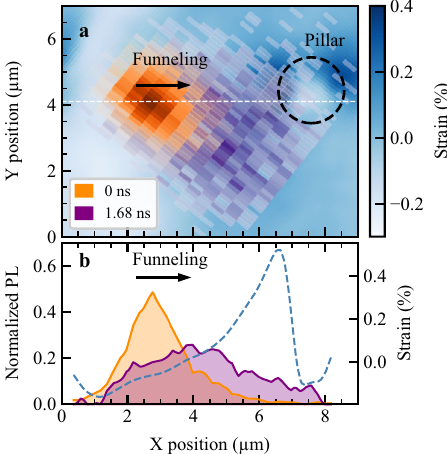
Fig. 4 Conventional exciton funneling in MoSe 2 monolayers. a Spatiotemporal photoluminescence of MoSe 2 shown at Δ t = 0 ns (orange area) and for a delay time of 1.68 ns (purple area) in presence of a strain pro fi le (blue scale). The dashed black circle denotes the position of the micropillar. b Cuts along the white dashed line in a . The dashed blue line shows the spatial strain pro fi le. We fi nd a conventional funneling towards region of higher strain in MoSe 2 (see also Movie